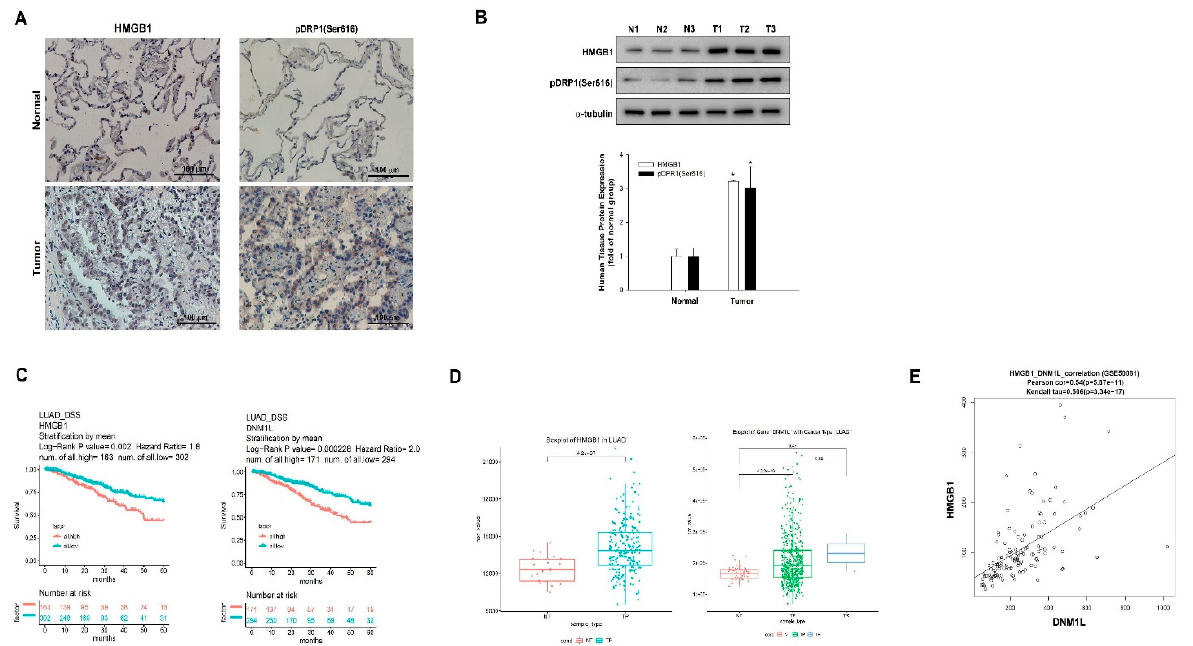
Figure 6. Elevated expression of HMGB1 and DNM1L ( DRP1 ) genes is associated with a poor outcome in NSCLC. ( A , B ) Expression of HMGB1 and pDRP1 (Ser616), respectively, in human normal or tumor tissues was examined by immunohistochemistry (IHC) and WB. * p < 0.01 compared with the control. ( C ) Effects of HMGB1 and DNM1L expression on overall survival in lung cancer patients were analyzed; the Kaplan–Meier plots were generated using a Kaplan–Meier Plotter obtained from the DriverDBv3 database (NT, TP, and TR) (http://driverdb.tms.cmu.edu.tw/) [30]. ( D ) Correlations between HMGB1 and DNM1L gene expression and 5-year overall survival rate of patients with lung cancer were obtained using the DriverDBv3 database. ( E ) Correlations of HMGB1 and DNM1L expression, the Pearson’s correlation, and Kendall’s tau coefficient tests were used to calculate the p value. NSCLC: non-small-cell lung cancer; N: normal lung tissue; T: lung tumor tissue.